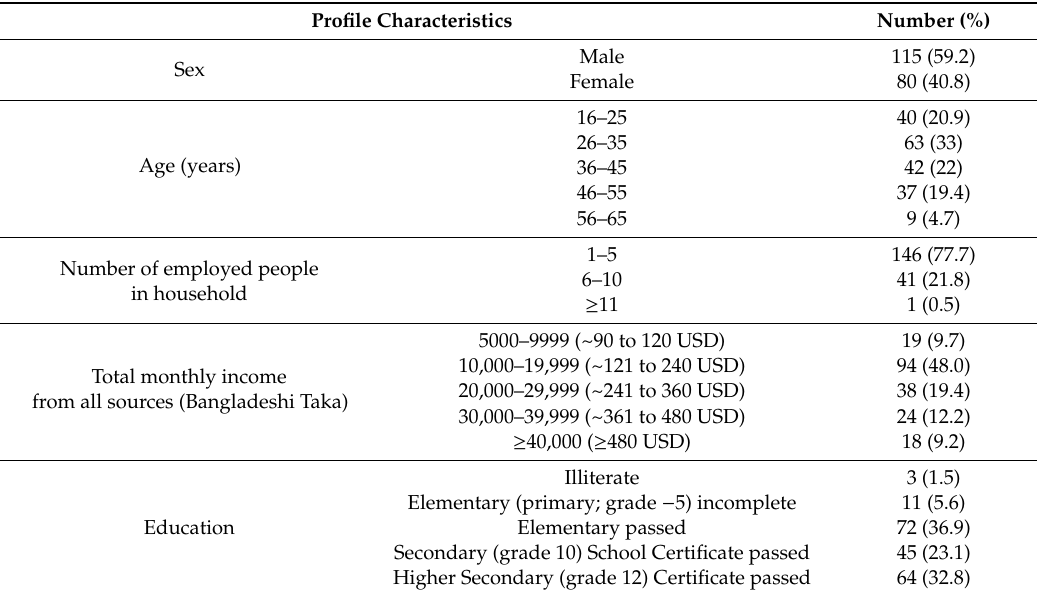
Table 1. Socio-demographic profile of consumers who participated in the dual-fortified lentil sensory evaluation study in Bangladesh.